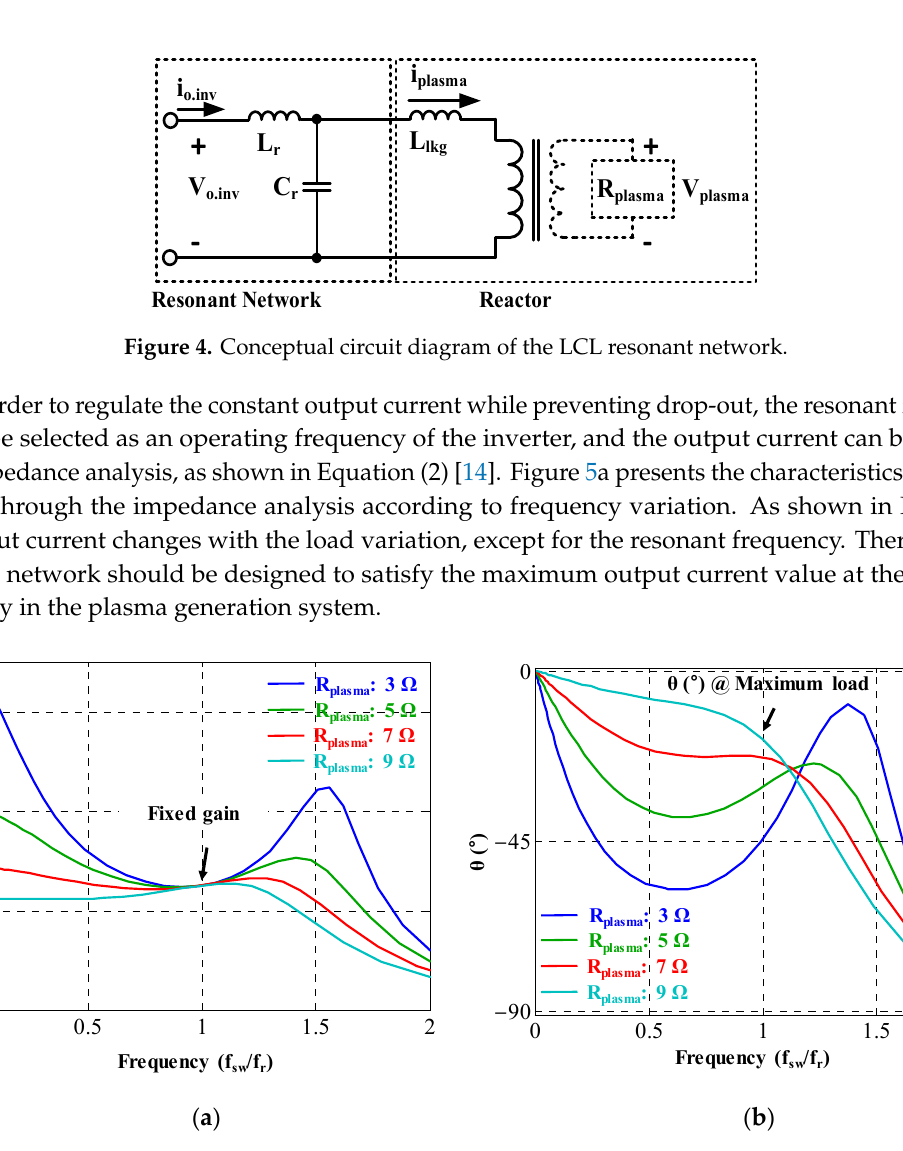
Figure 4. Conceptual circuit diagram of the LCL resonant network.